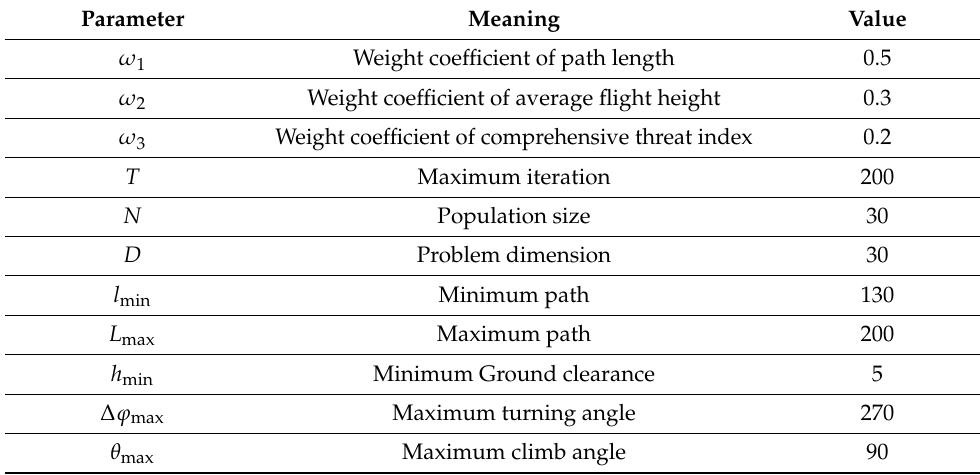
Table 2. Initial parameter of